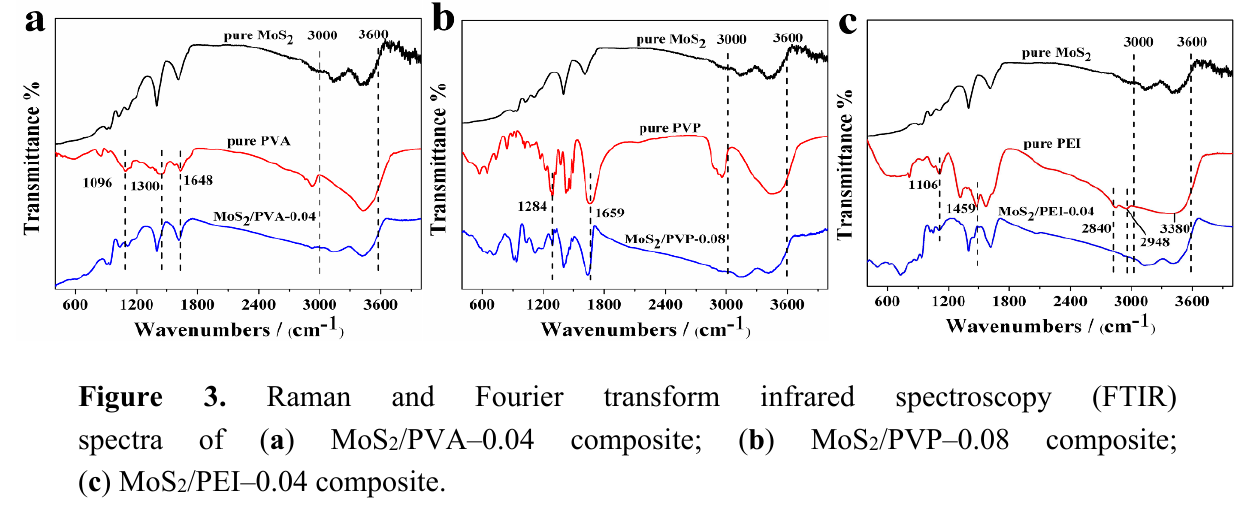
Figure 3. Raman and Fourier transform infrared spectroscopy (FTIR) spectra of ( a ) MoS 2 /PVA–0.04 composite; ( b ) MoS 2 /PVP–0.08